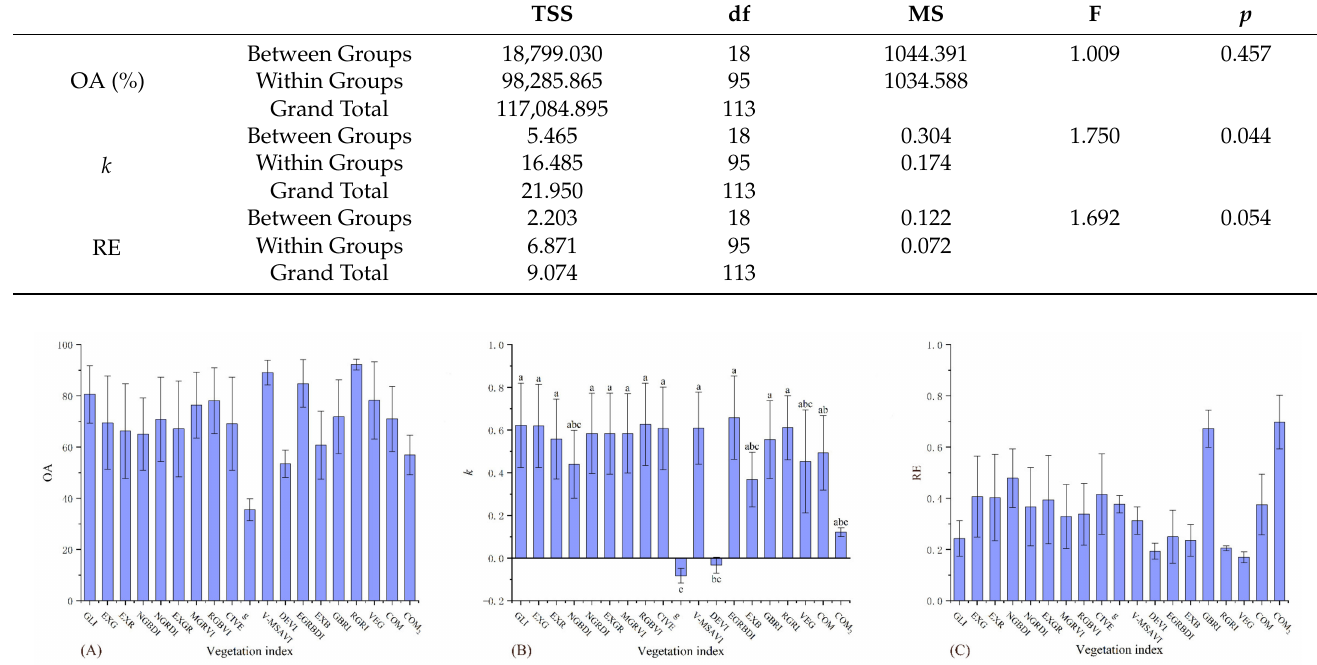
Table 8. OA, k , and RE differences of 19 vegetation indices on the non-desertification grade.